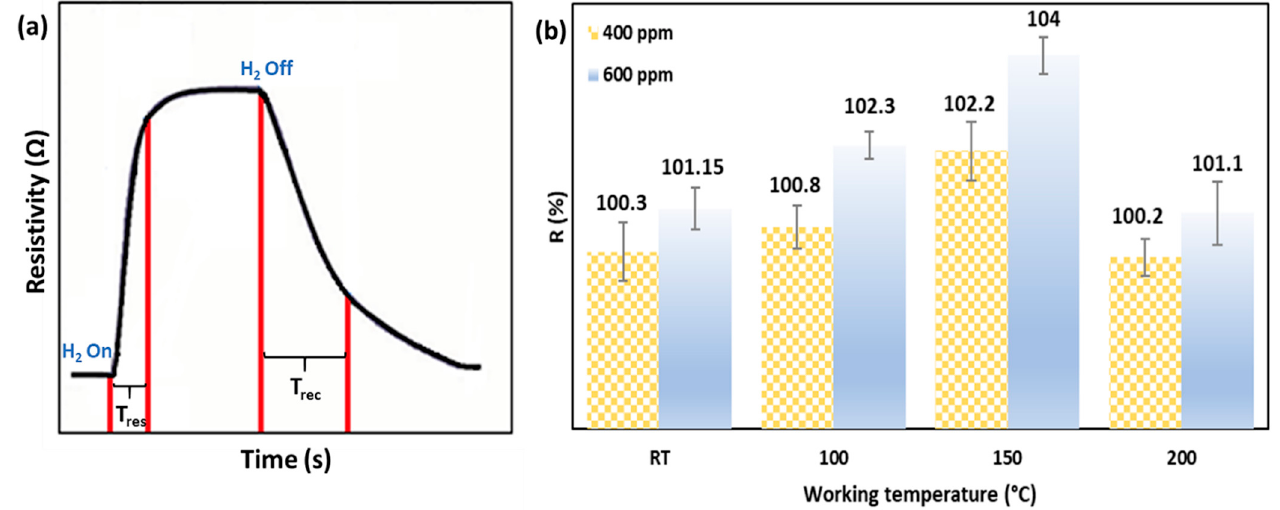
Figure 8. ( a ) P-type semiconducting sensing behaviour towards H 2 as a reducing gas, T res : response time, and T rec : recovery time; and ( b ) Response of the Dy 2 O 3 -Pd-PDA/rGO sensor towards 400 and 600 ppm hydrogen at different working temperatures.